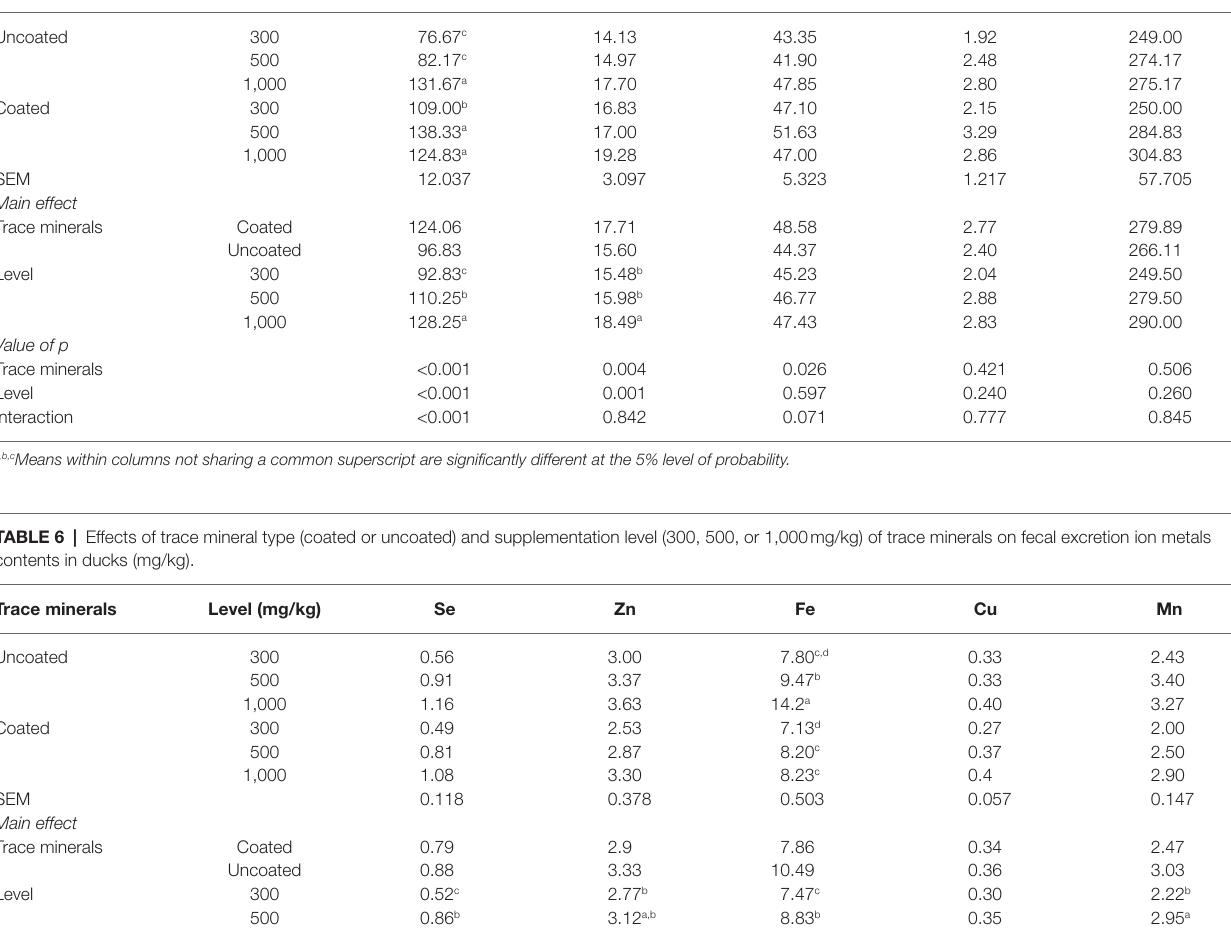
TABLE 5 | Effects of trace minerals type (coated or uncoated) and supplementation level (300, 500, or 1,000mg/kg) of muscle mineral deposition in ducks. Trace minerals